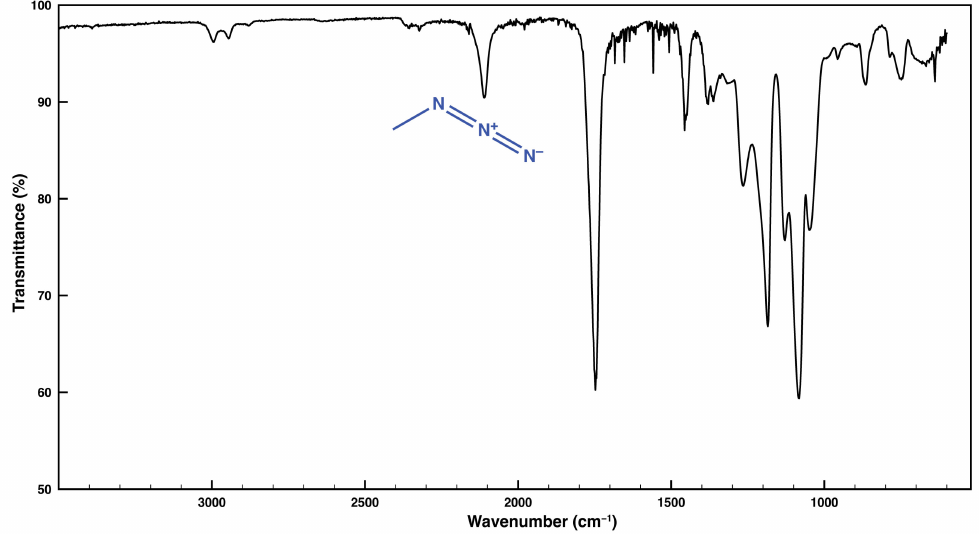
Figure 2. FTIR spectrum of multi-azide-functional N 3 -PLA- co -PAMTC